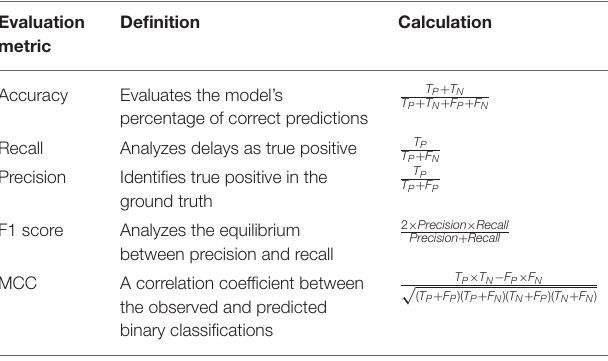
TABLE 1 | Classification performance metrics used in the